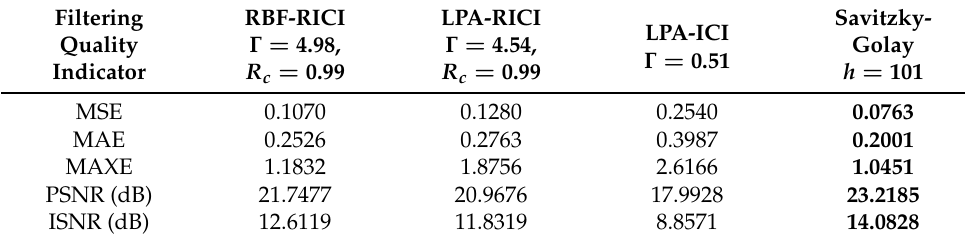
Table 23. HeaviSine signal (SNR = 7 dB)—Filtering results.